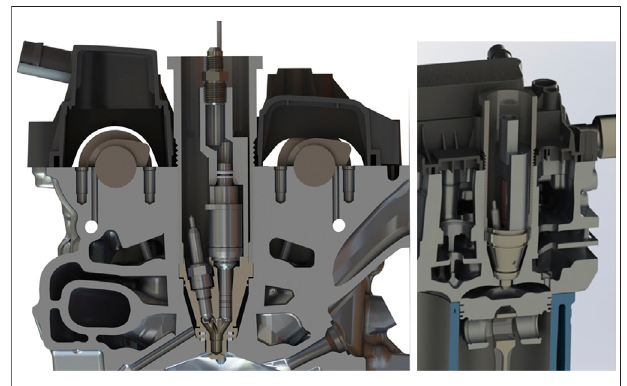
FIGURE 1 | Cutaway of the MJI pre-chamber (left) and MJI pre- chamber assembly (right) in a typical passenger car engine cylinder